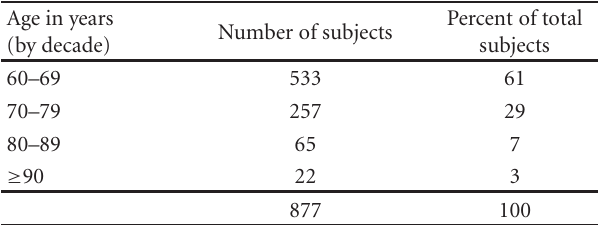
Table 1: Categorizationof elderly Hmongsubjects by chronological